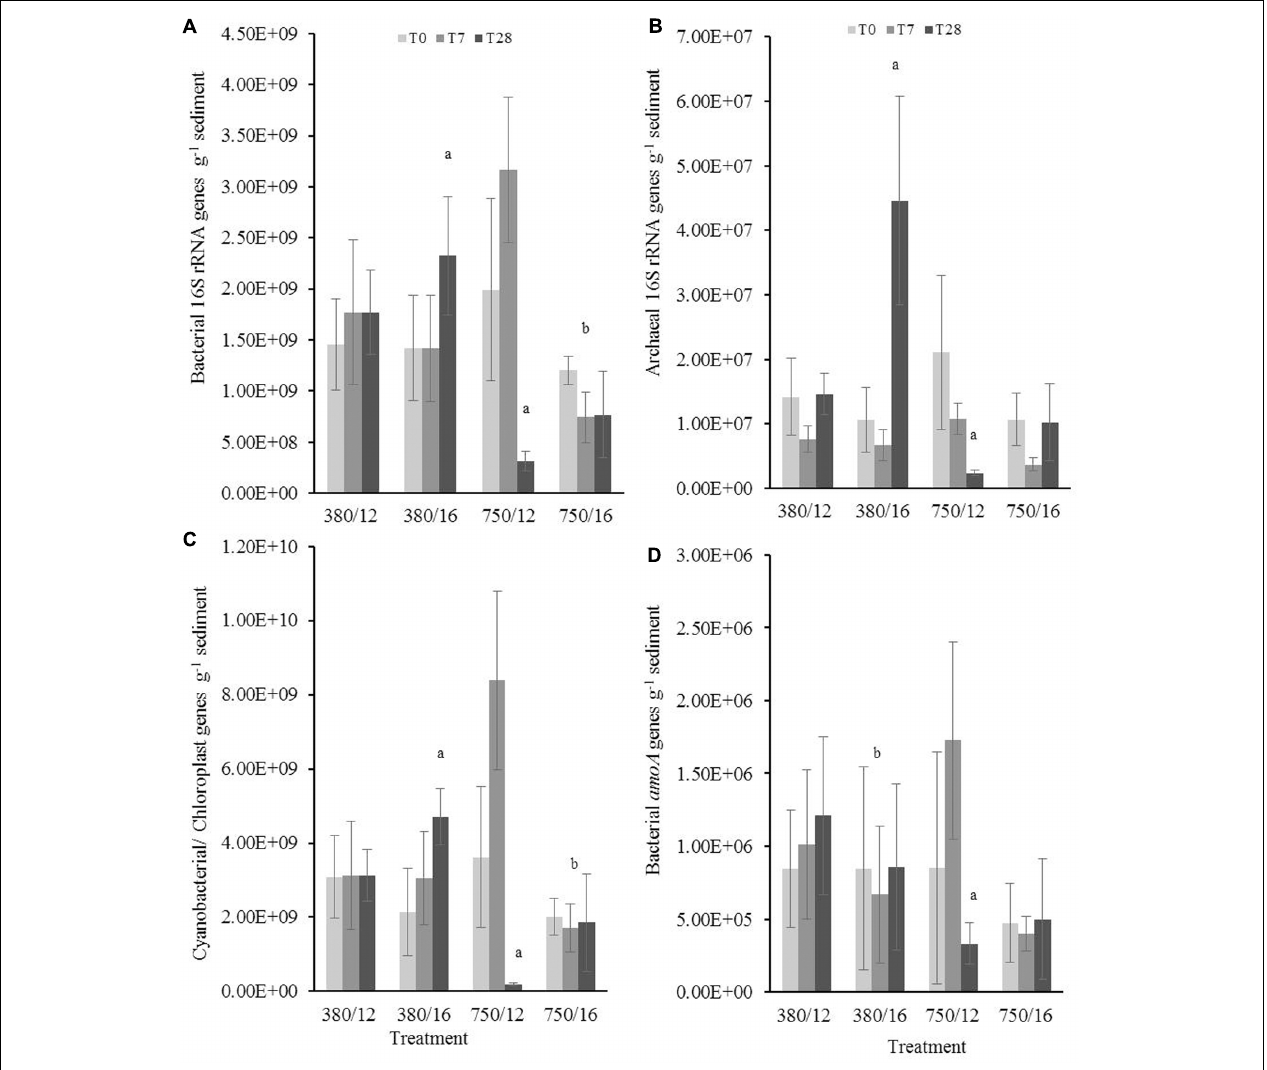
FIGURE 3 | The independent and interactive effects of CO 2 and or temperature on the abundance (g − 1 sediment) of (A) bacterial 16S rRNA, (B) archaeal 16S rRNA, (C) cyanobacterial/chloroplast 16S rRNA, and (D) bacterial amoA genes in the upper layer (0–0.5 cm) of muddy sediment. Four syringe cores were taken at each time point (T0, light gray; T7, dark gray; and T28, black) from each environmental treatment ( x -axis). Significant effects from the model output are indicated by the letter a (where there is an interaction with day); b (interaction between elevated CO 2 and elevated temperature). Error bars represent standard deviation of repeated measurements ( n = 4) from treatment replicates ( n =